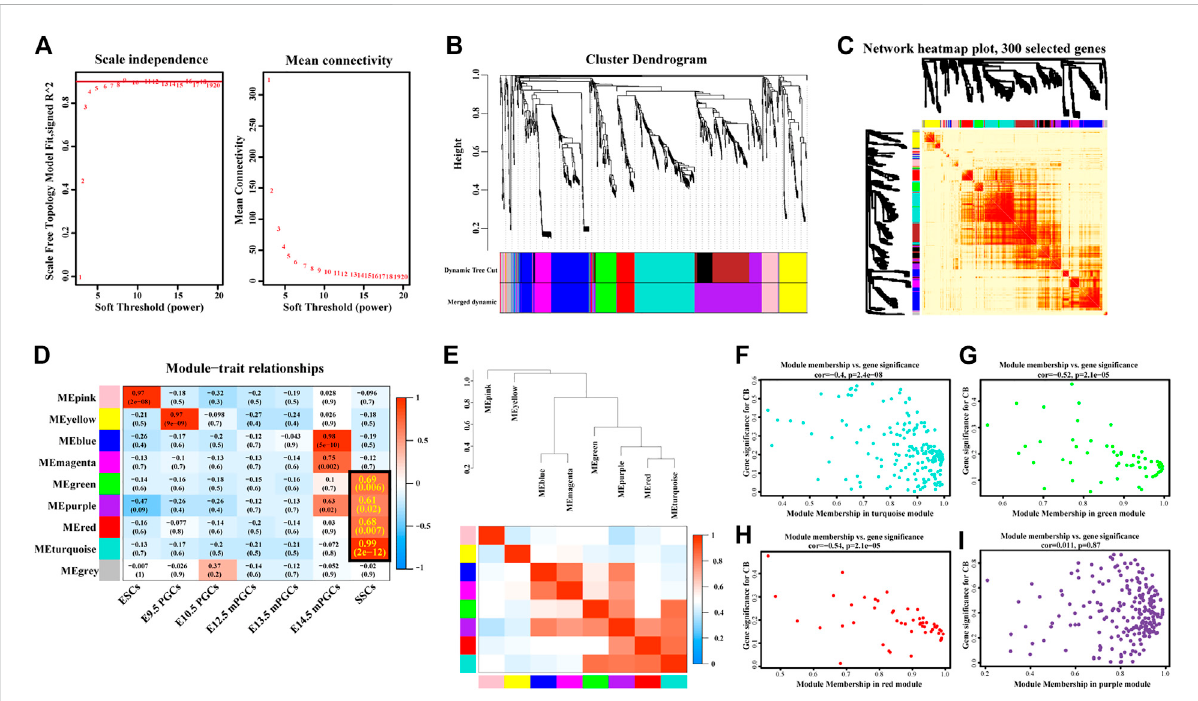
FIGURE 5 Construction of coexpression modules by WGCNA. (A) Scale-free index analysis for soft-threshold power and mean connectivity analysis for various soft-threshold powers. (B) Hierarchical clustering tree was developed by the weighted correlation coef fi cients. Each branch represents a coexpression module in different colours. (C) Interaction relationship analysis of coexpressed genes. The branch in the hierarchical clustering dendrograms corresponds to each module. Different colours of the horizontal axis and vertical axis represent different modules. The more saturated red indicates the higher coexpression interconnectedness in the heatmap. (D) Heatmap of the correlation between modulesand hallmark gene sets. The framed turquoise, green, red, and purple modules were the most positively correlated with SSCs. Gene signi fi cance (GS) and its corresponding p-value werecomputedandareshownintheheatmap. (E) Hierarchicalclusteringofmodulehubgenesthatsummarizethemodules yieldedintheclusteringanalysis(top)andheatmapplotoftheadjacenciesinthehubgenenetwork (below). (F – I) ScatterplotoftheGSforthegrade vs. the MM in the turquoise (F) , green (G) , red (H), and purple (I)